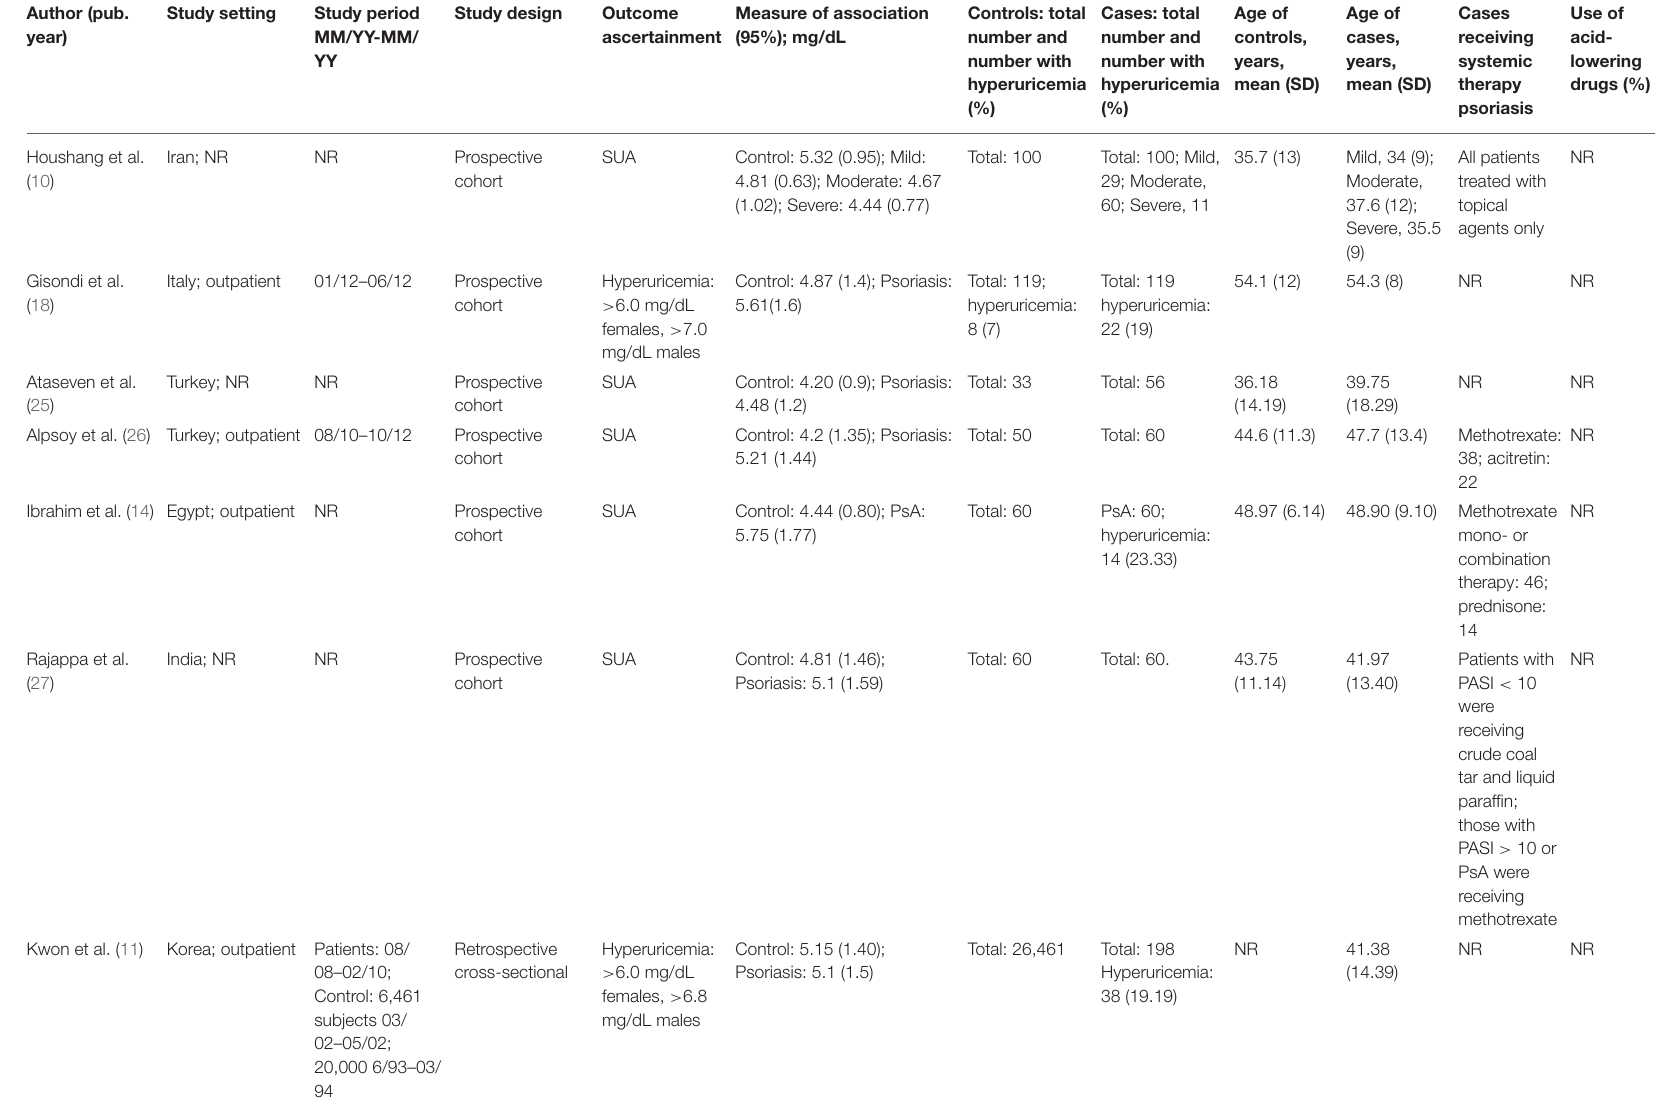
TABLE 1 | Observational studies included in the